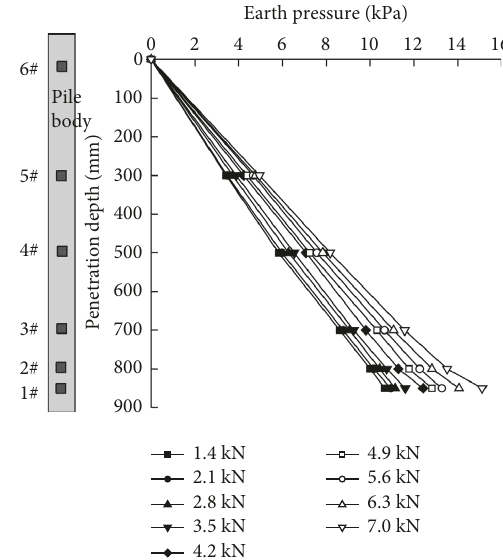
Figure 10: Variation of earth pressure at the pile-soil interface of TP2 with depth under various loads.